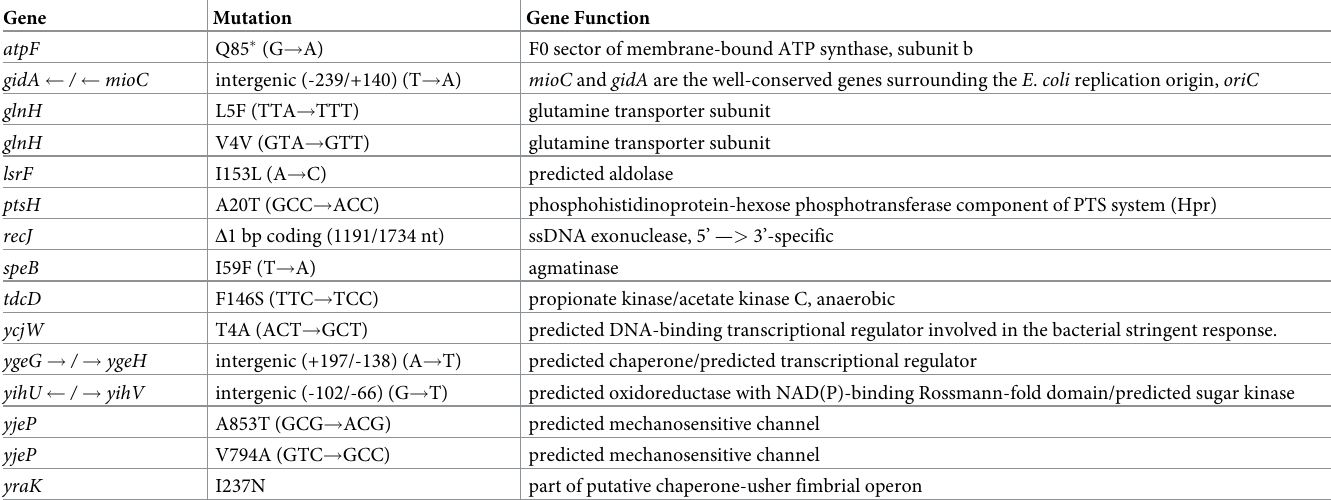
Table 3. Mutations in the TLD-resistant evolved isolate in the MDS42 background. Gene Mutation